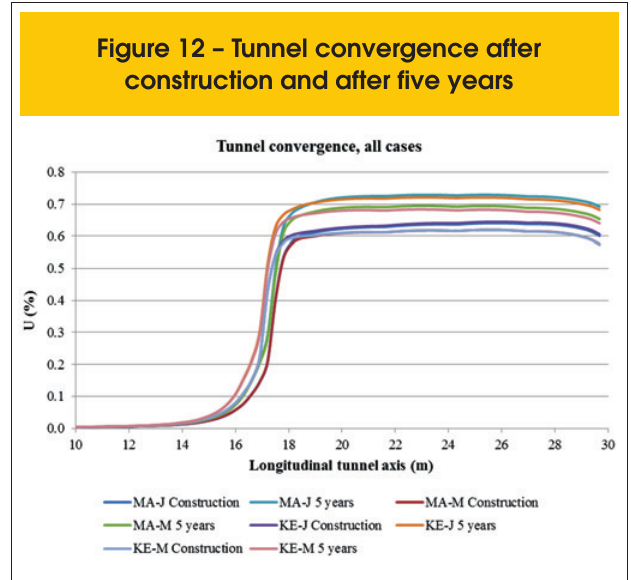
Figure 12 – Tunnel convergence after construction and after five